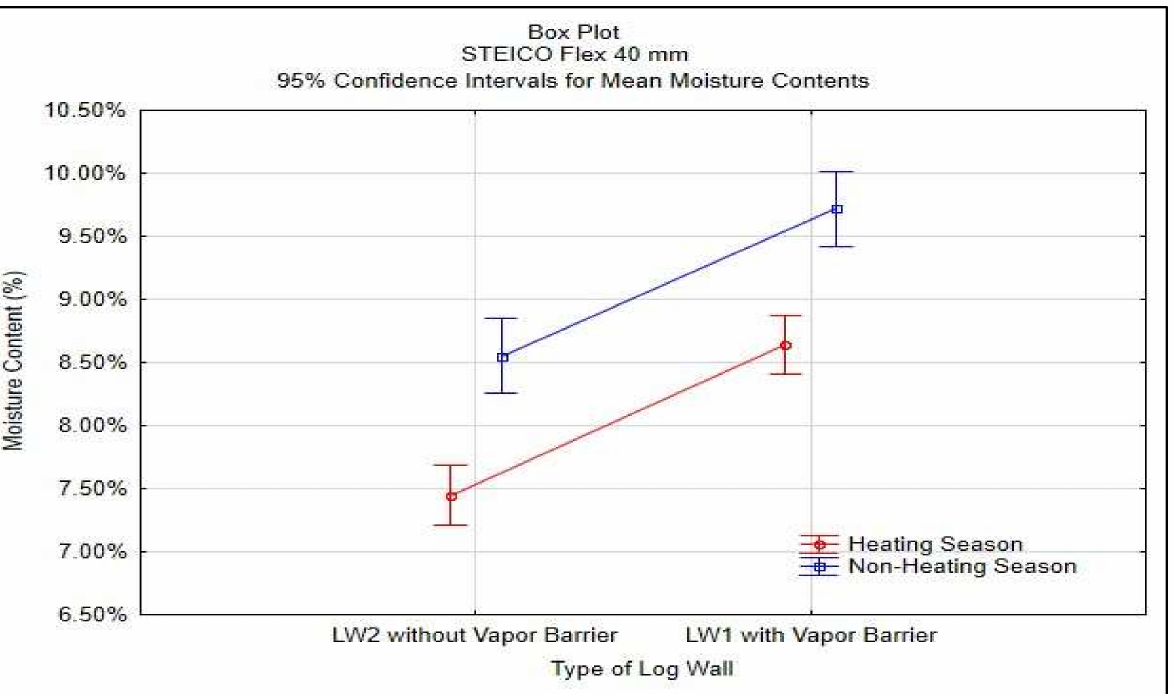
Figure 9. 95% Confidence Intervals for Mean Moisture Contests of STEICO Flex width 40